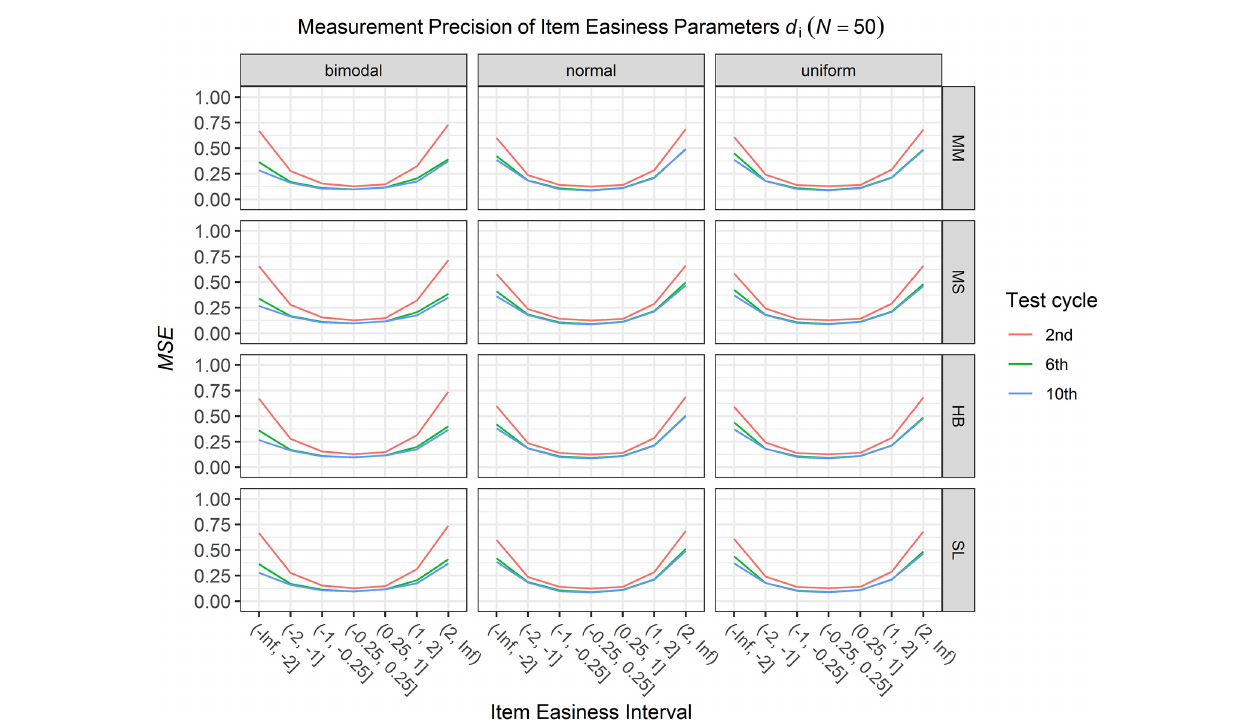
FIGURE 4 | Conditional mean squared error ( MSE ) of the item easiness d i for specific item easiness intervals after the 2nd, 6th, and 10th test cycle in the continuous calibration strategy with a sample size per test cycle of N = 50 for different common item difficulty distributions and different scale transformation methods (MM = Mean/Mean, MS = Mean/Sigma, HB = Haebara, SL =